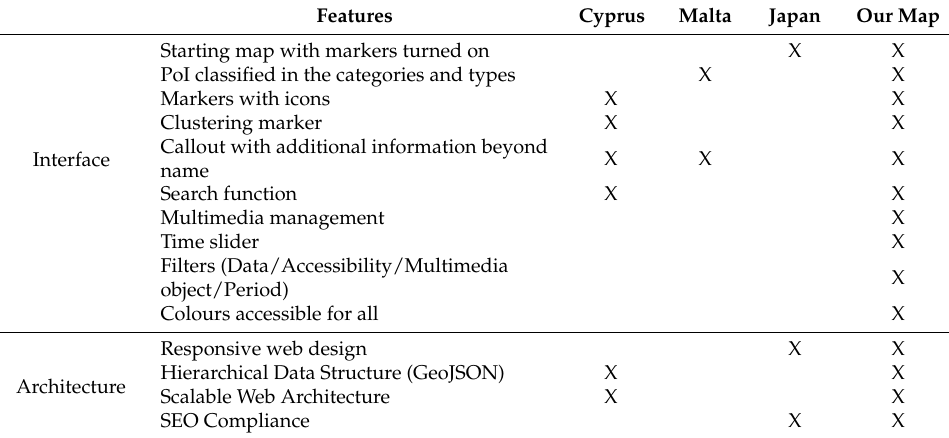
Table 1. Comparison of the features of the interactive maps used in the case studies and our map (non-functional and/or incomplete content functions are considered absent). PoI, Point of Interest; SEO, Search Engine